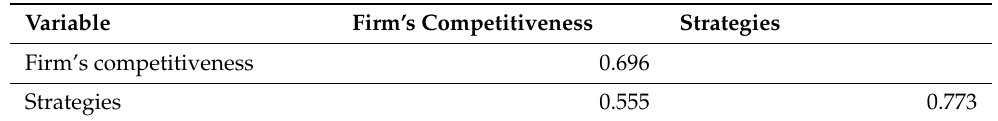
Table 10. Correlation matrix to assess the discriminant